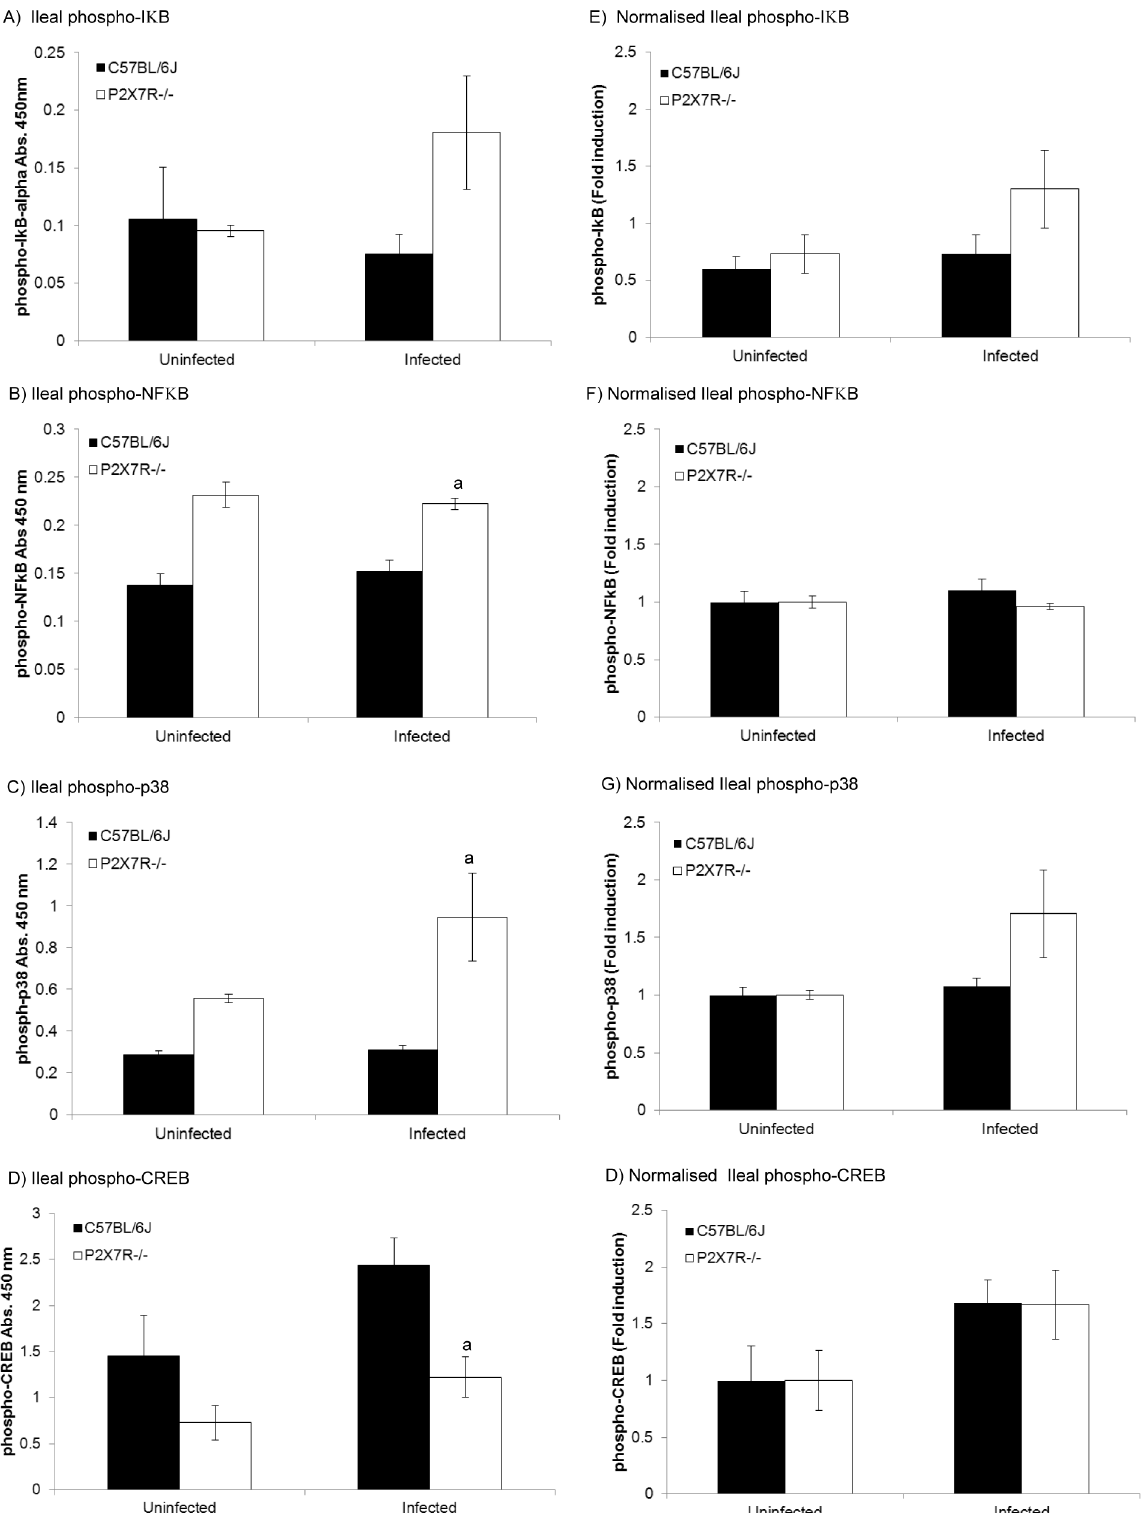
Fig 4. Regulation of transcriptional regulators is impaired in P2X7R -/- mice compared with wild type in association with toxoplasmic ileitis. Male mice (6 – 8 weeks old) were infected orally with 10 T . gondii Me49 cysts and euthanased 8 days post-infection. Ileal homogenates were collected